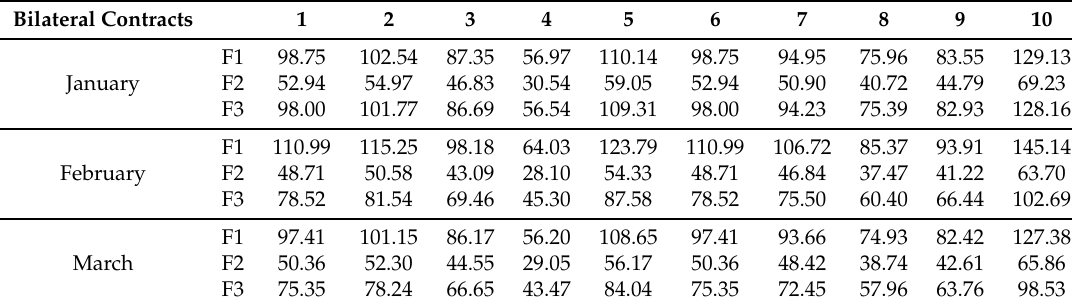
Table A4. Bilateral contracts upper bounds